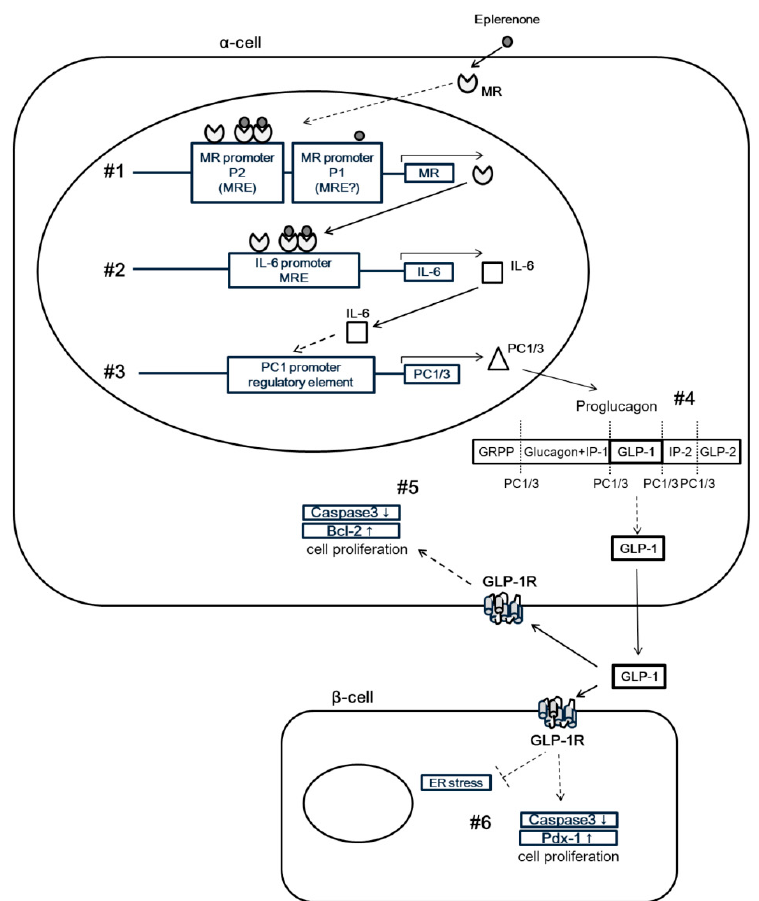
Figure 8. Proposed mechanism for MR in pancreatic islets. MR signal exerts a protective function in islets through IL-6 induction, which promotes active GLP1 secretion through PC1/3 activation. (1) MR induced from eplerenone, alone or in an eplerenone-MR complex, may bind to MRE in P2 in α -cells and promote MR expression. (2) MR and/or an eplerenone-MR complex may bind to the MRE in the IL-6 promoter to drive IL-6 expression. (3) IL-6 activation leads to increased PC1/3 mRNA levels and (4) induced PC1/3 may cleave proglucagon into GLP-1 in α -cells, resulting in elevated plasma levels of GLP-1. (5) Autocrine signaling of GLP-1 in α -cells may increase the expression of Bcl-2 mRNA and reduce the levels of caspase-3 mRNA, leading to protection of α -cells from apoptosis. (6) Paracrine signaling of GLP-1 in β -cells may increase the expression of Pdx-1 mRNA and reduce the levels of caspase-3 mRNA, thus protecting β -cells from endoplasmic reticulum stress and apoptosis.